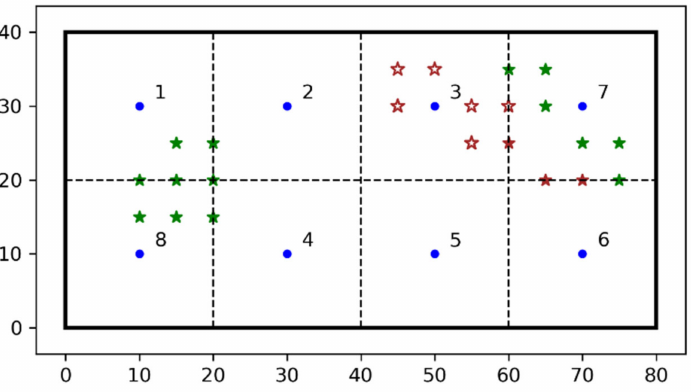
) best locations for a new store of the ninth ★